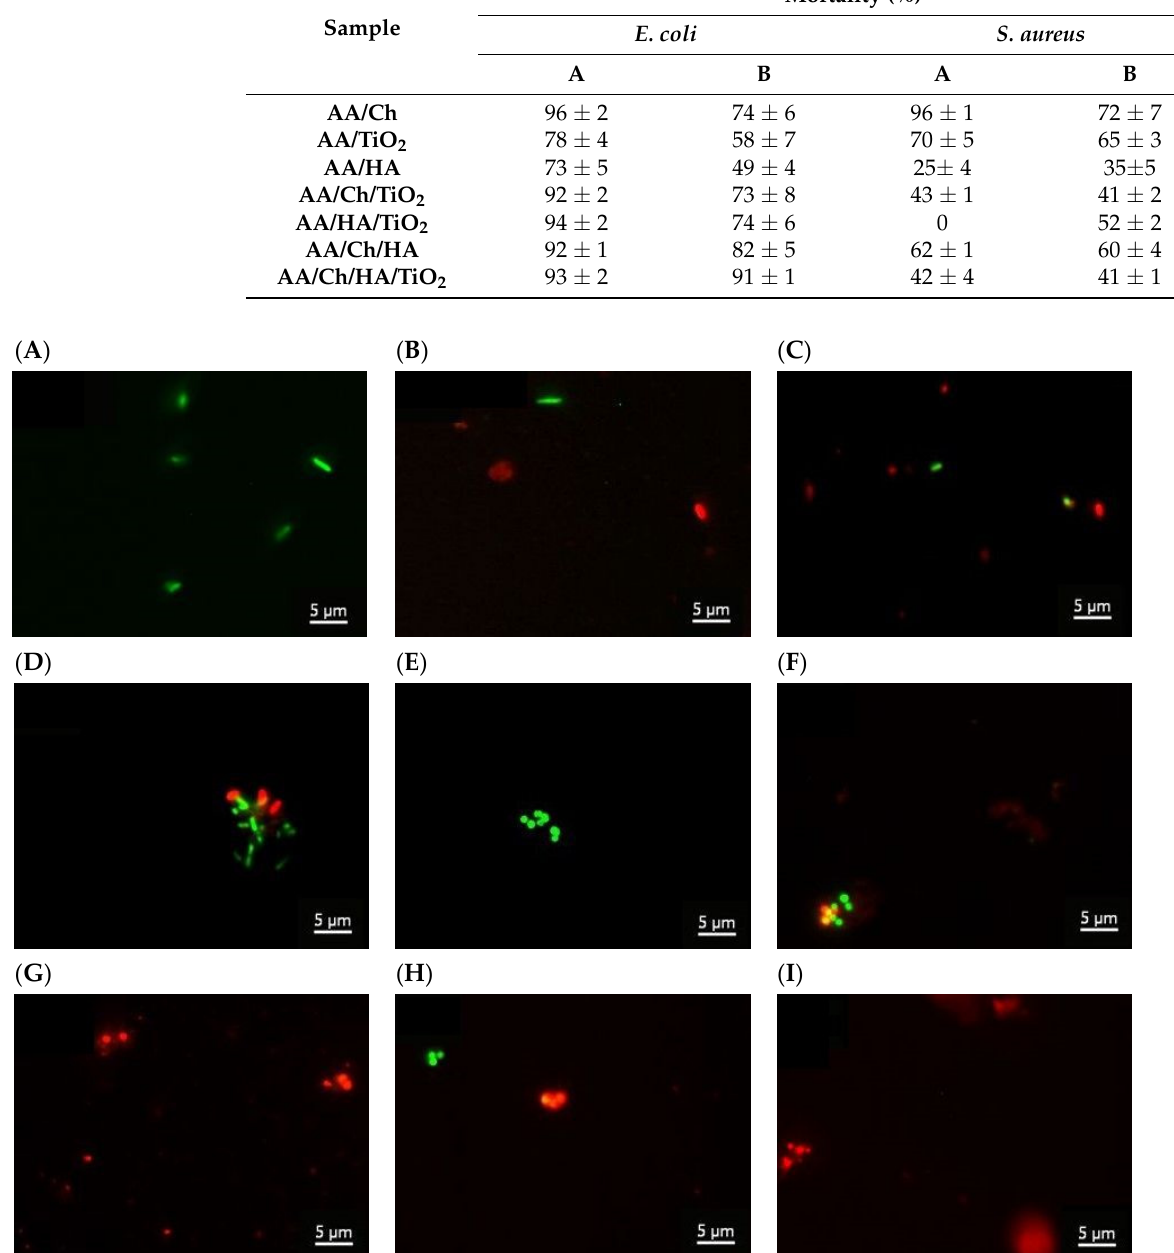
Figure 10. E. coli with Live/Dead staining and imaged with LSCM. The green signal is due to the dye SYTO9, indicating alive cells while the red signal is due to PI which marks the dead cells. ( A ) E. coli control, ( B ) E. coli treated with AA/TiO 2 , ( C ) E. coli treated with AA/Ch, ( D ) E. coli treated with AA/Ch/HA/TiO 2. S. aureus with Live/Dead staining and imaged with LSCM. ( E ) S. aureus control, ( F ) S. aureus treated with AA/TiO 2, ( G ) S. aureus treated with AA/Ch, ( H ) S. aureus treated with AA/HA, ( I ) S. aureus treated with AA/Ch/TiO 2 . Magnification 1000 × . Similar to E. coli , chitosan was also very active against S. aureus , as the killing effect was 96% in the CFU counting test and 72% in Live/Dead staining. AA/TiO 2 was the second most lethal suspension against S. aureus . Although chitosan and TiO 2 alone were the